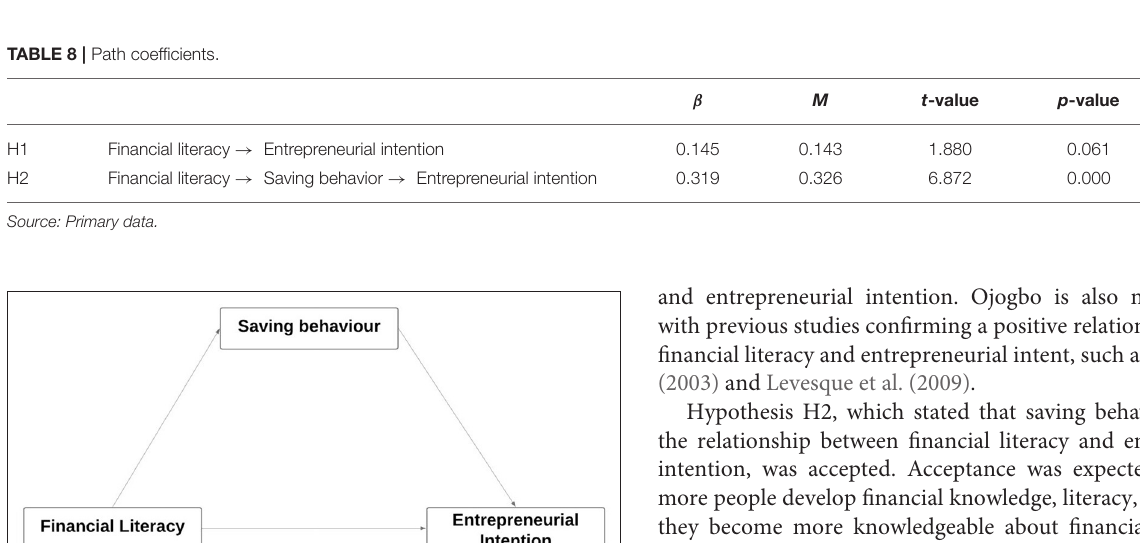
previously mentioned relationships. As a result, H2 was accepted ( β = 0.319, P <